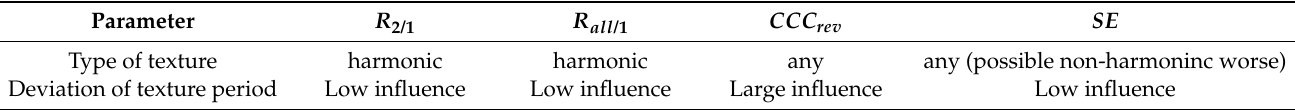
Table 7. Applicability of shape deviation metrics on identification of target-like